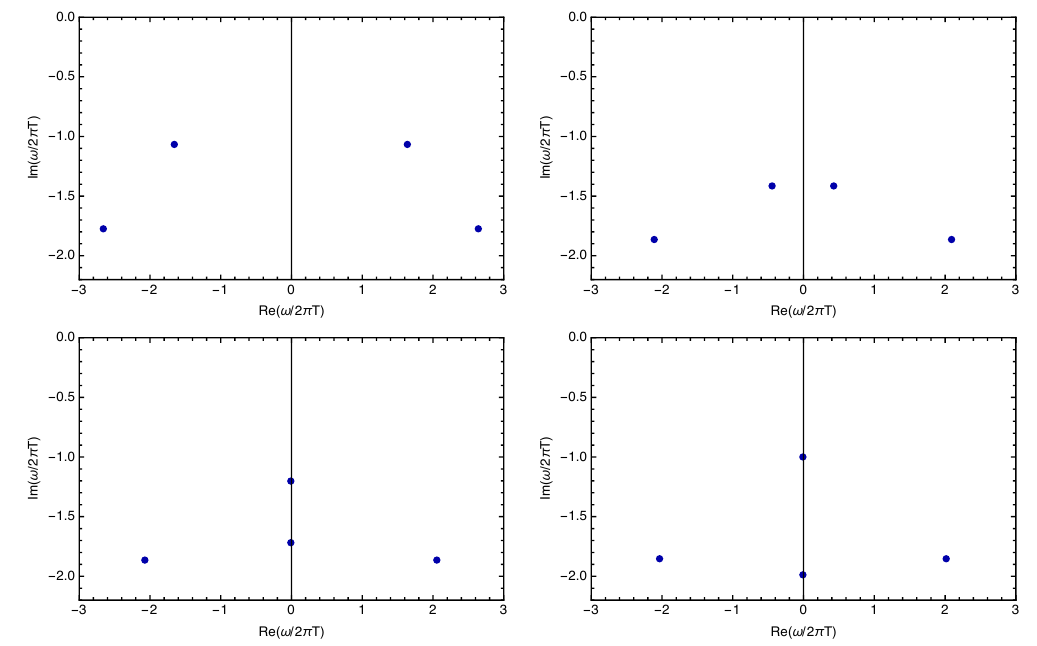
Figure 2 . Blue dots denoting the location of poles of the boundary retarded Green’s function for a massless scalar (cid:12)eld in AdS 6 -Schwarzschild. The locations were determined numerically (using the procedure described in section 4.2 of [24]) for four values of k=r 0 : 0 (top left), 3 : 0 i (top right), 3 : 1 i (bottom left) and 3 : 16 i (bottom right). The pole locations are consistent with our near-horizon p analysis, which indicates that k 1 =r 0 = k 2 =r 0 = 10 i (cid:24) 3 : 16 i is a pole-skipping wavenumber for the (cid:12)rst two pole-skipping frequencies ! 1 and ! 2